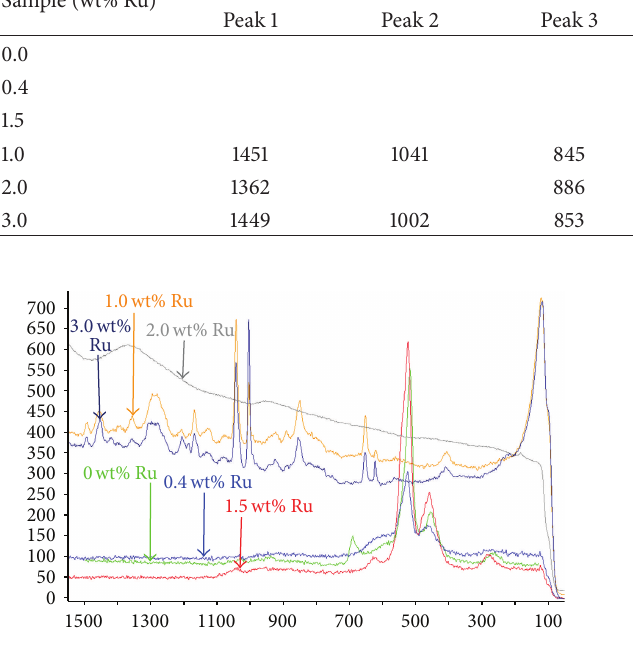
Figure 5: Raman spectra of all the alloys after exposure to 1M sodium chloride solution.